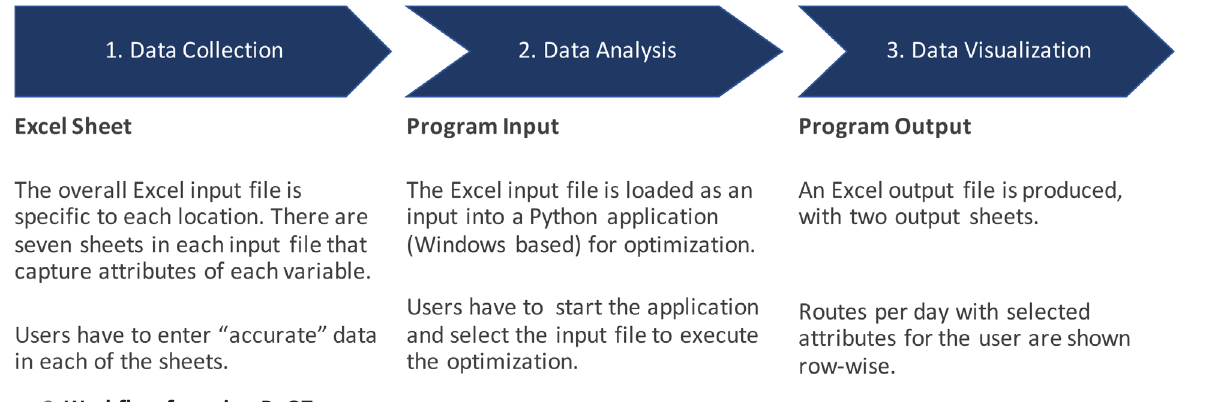
Figure 2. Workflow for using